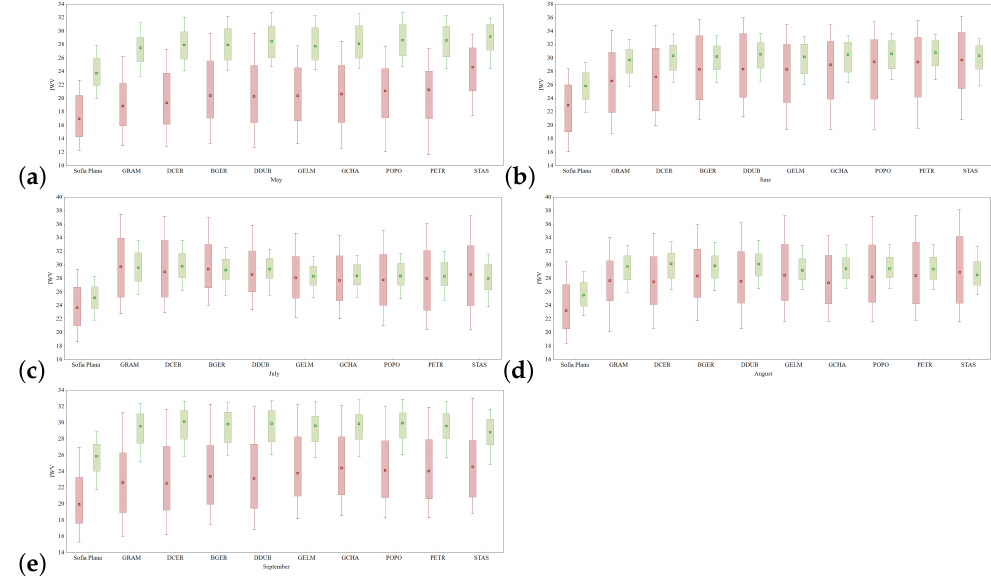
Figure 4. GNSS IWV (red box) and WRF IWV+ (green box) monthly box and whisker plots for the period May–September 2021 ( a – e ).